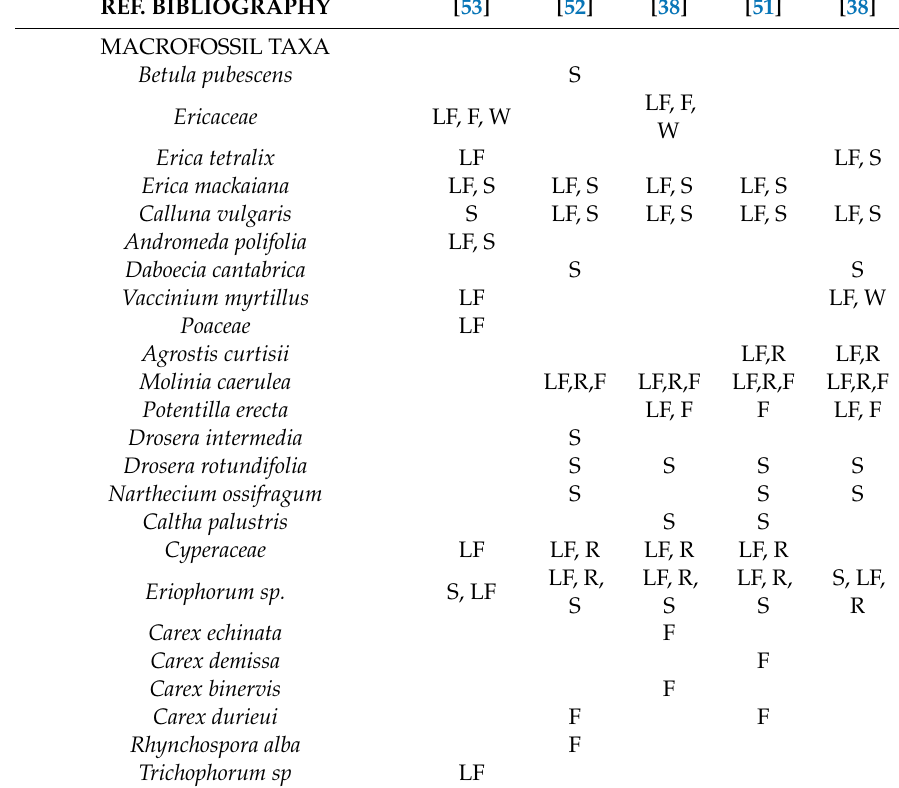
Table 2. Macrofossil taxa for ombrotrofic mires in North of Spain. Abbreviations: S—seeds, correspond to the numbering in the